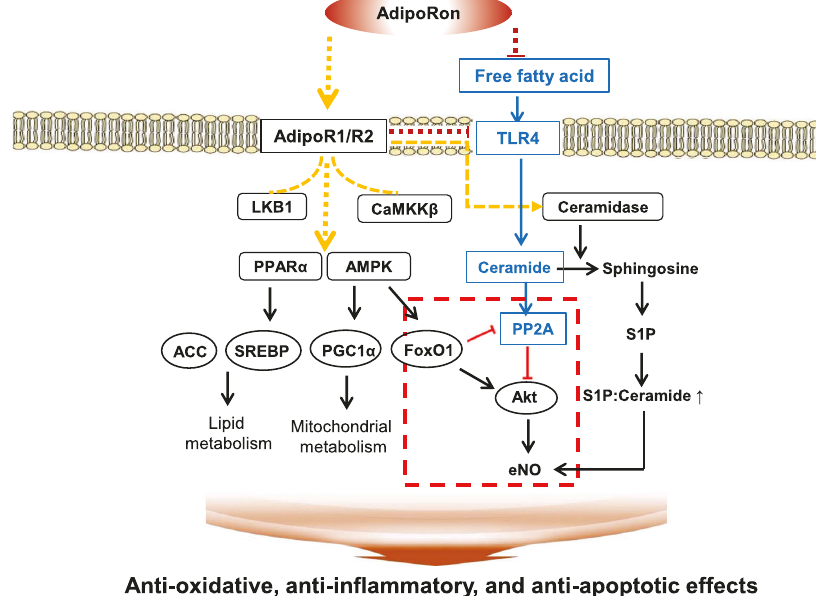
Fig. 8 Cardiomyocyte survival and proliferation by adiponectin receptor agonism. Adiponectin receptor agonism activates CaMKK β , LKB1, AMPK and PPAR α . It also has ceramidase activity and can catalyze the conversion of ceramide to sphingosine, which produces S1P, subsequently increasing S1P to ceramide ratio that further ameliorates endothelial dysfunction through increased NO level. Activation of associated downstream pathways exert prometabolic effects by enhancing fatty acid oxidation and mitochondrial biogenesis. Red dottedlines: Constitutive activation of FoxO1 by AMPK represses PP2A and its interaction with Akt, subsequently increasing Akt phosphorylation, which would otherwise have been dephosphorylated by continuous inhibitory effect of PP2A with subsequent inhibition of eNOS through ceramide biosynthesis. The net result is the improvement of ceramide-induced oxidative stress via pro-metabolic effects of adiponectin agonism in which pAMPK-induced FoxO1 activation might play a crucial role in modulating its receptor